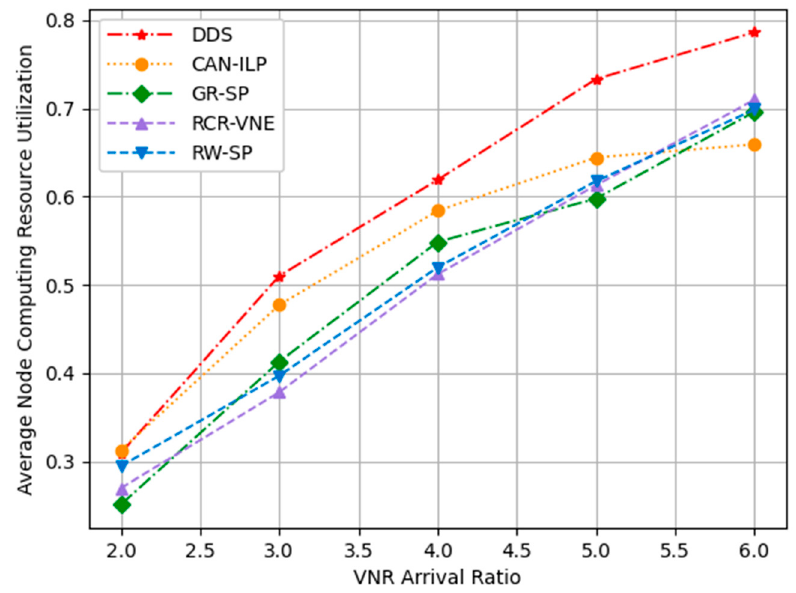
Figure 7. Average node computing resource utilization under various VNR arrival